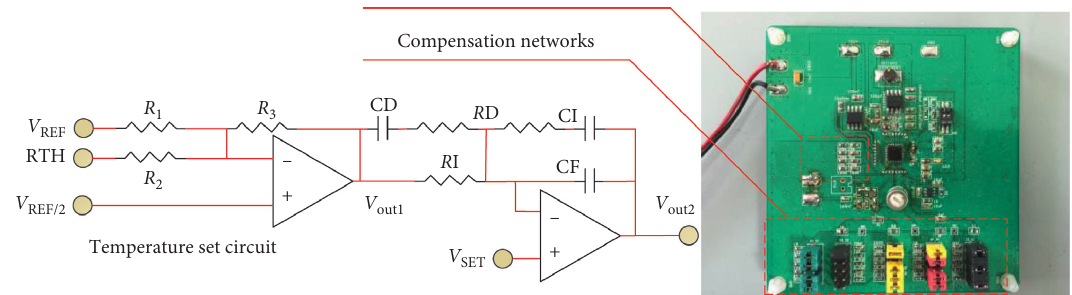
Figure 3: Laser temperature control and modulation board using ADN8831.